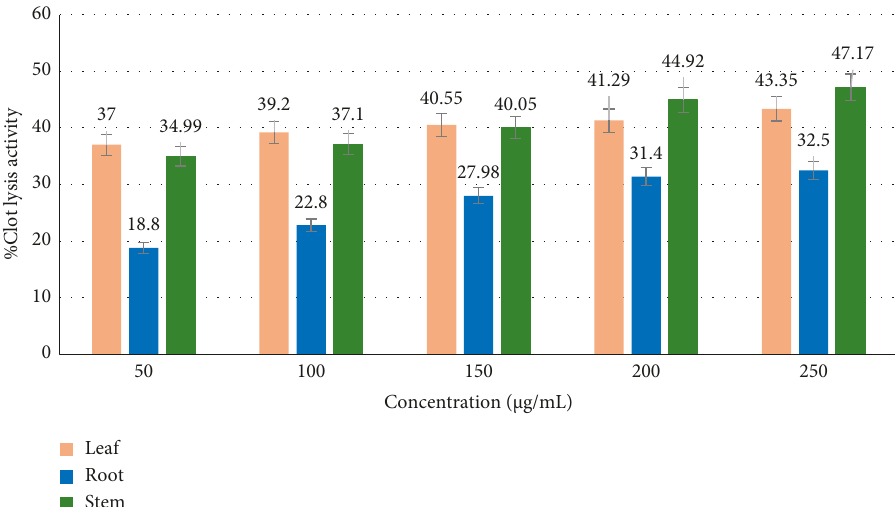
Figure 6: Thrombolytic activity of C. lanatum